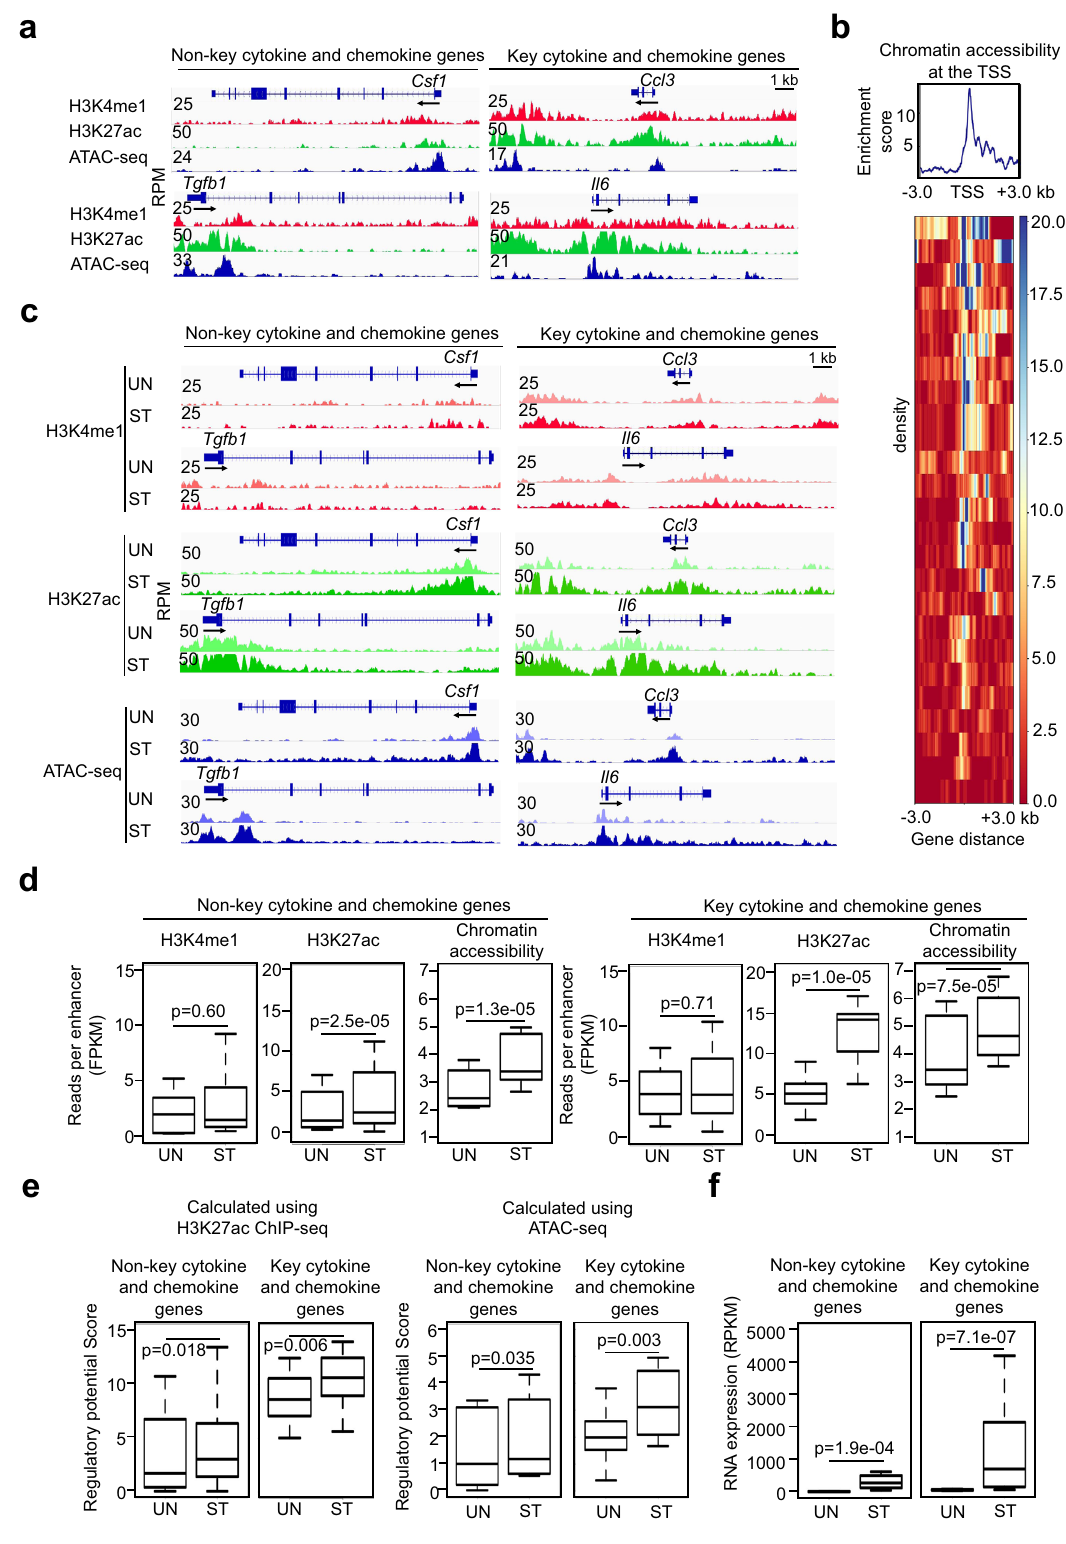
genes also display enriched H3K27ac, a histone modi fi cation mark for actively transcribed genes, prior to stimulation by IgE receptor crosslinking (Fig. 6a). Moreover, these genes feature accessible chromatin at their proximal promoters, as measured by Omni-ATAC-seq (Fig. 6b). Our data support a model in which cytokine and chemokine genes are poised with an “ open